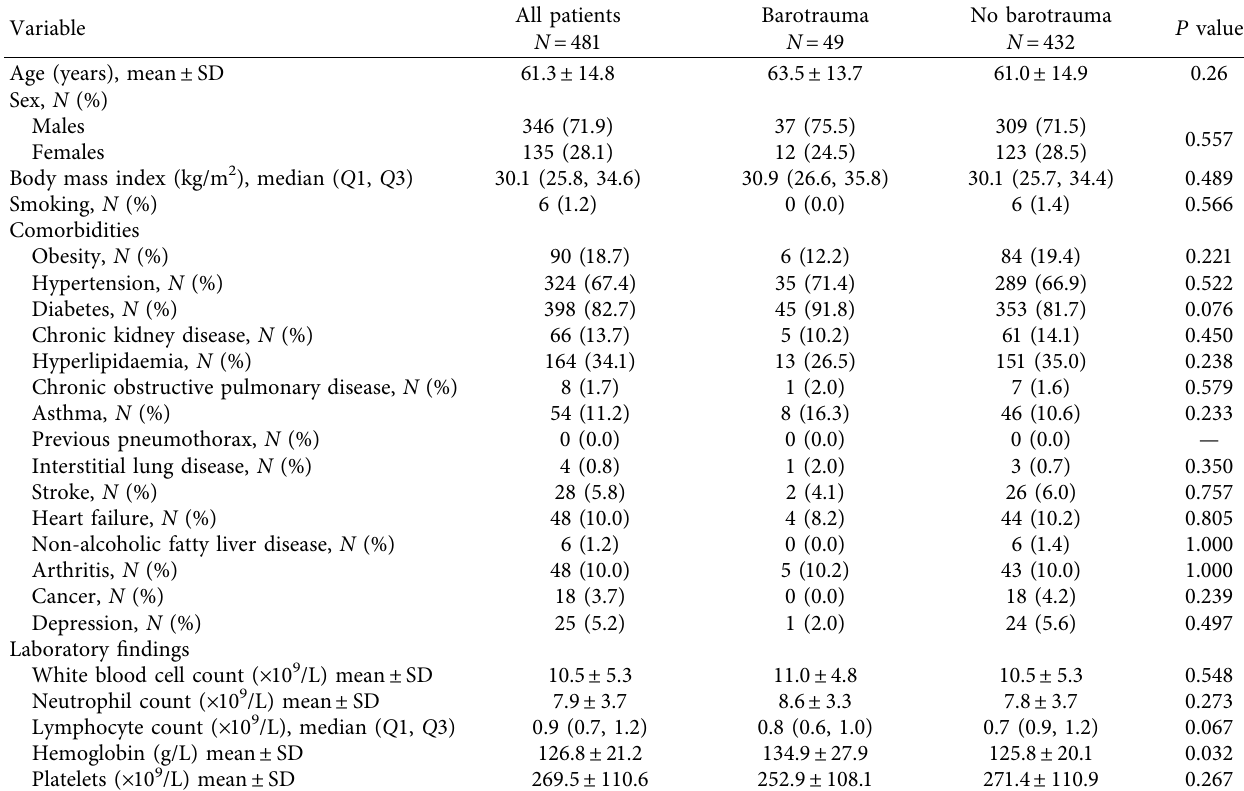
Table 1: Baseline characteristics of patients with critical COVID-19.